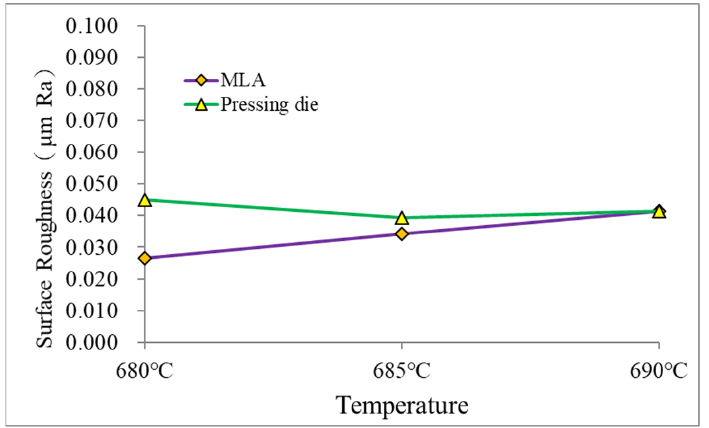
Figure 6. Effects of temperature on surface roughness between pressing die and MLA.